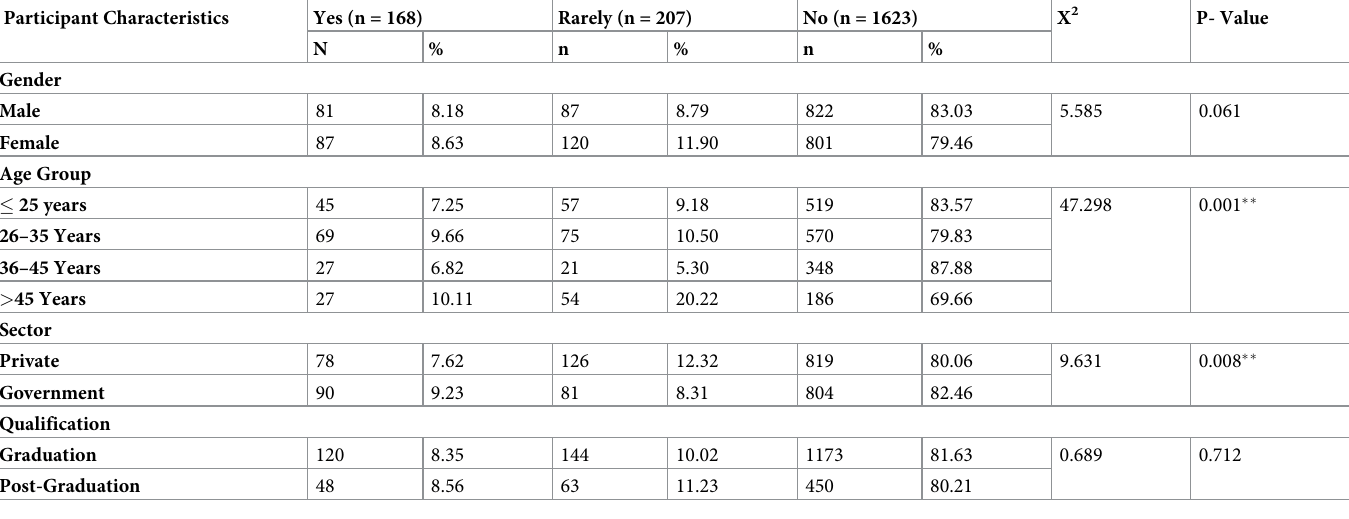
Table 7 represented the comparison between respondents who were using sleeping pills to attain proper sleep and those who were not using sleeping pills by socio-demographic Table 7. Participants using sleeping